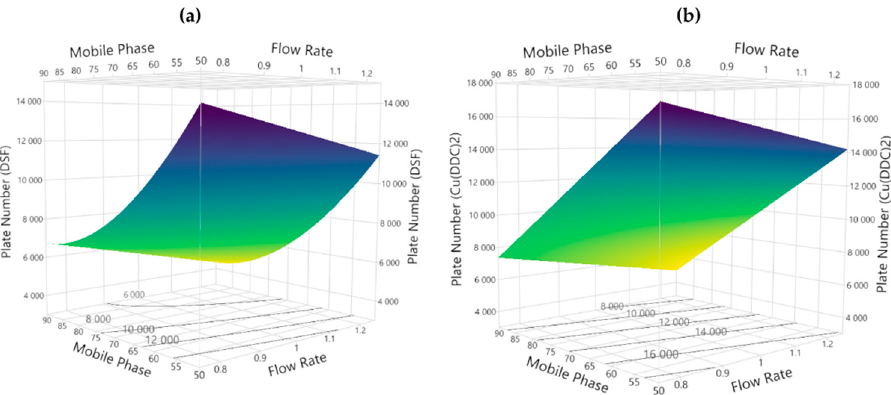
Figure 5. Three-dimensional response surface plot for the effect of flow rate (X 1 ) and mobile phase composition (X 2 ) on DSF ( a ) and Cu(DDC) 2 . ( b ) Theoretical plates number.